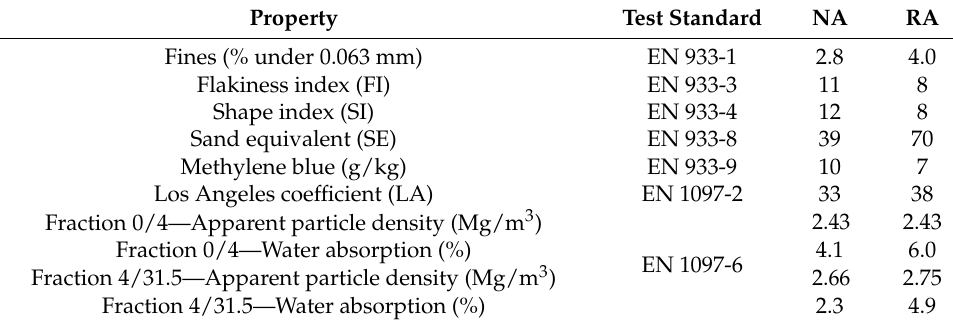
Table 3. Properties of the natural and recycled aggregates.